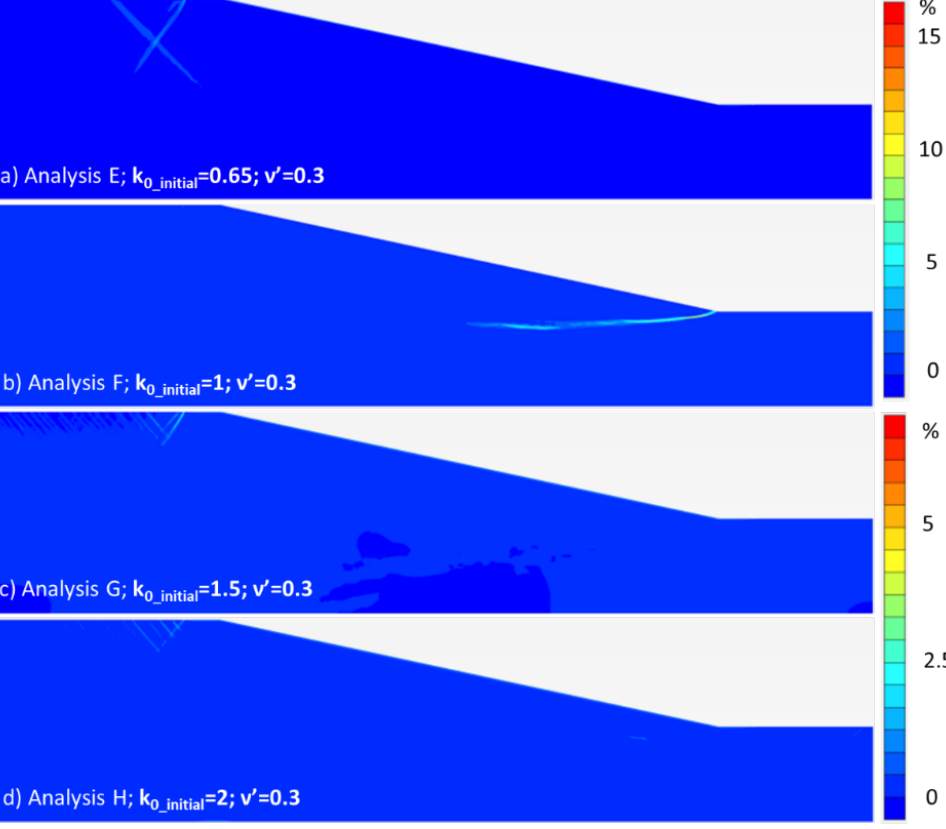
Figure 13. Cumulated shear strain after 10 years of net rainfall at the ground surface; a ) analysis E, b ) analysis F, c ) analysis G and d ) analysis H. b ) analysis F, c ) analysis G and d ) analysis